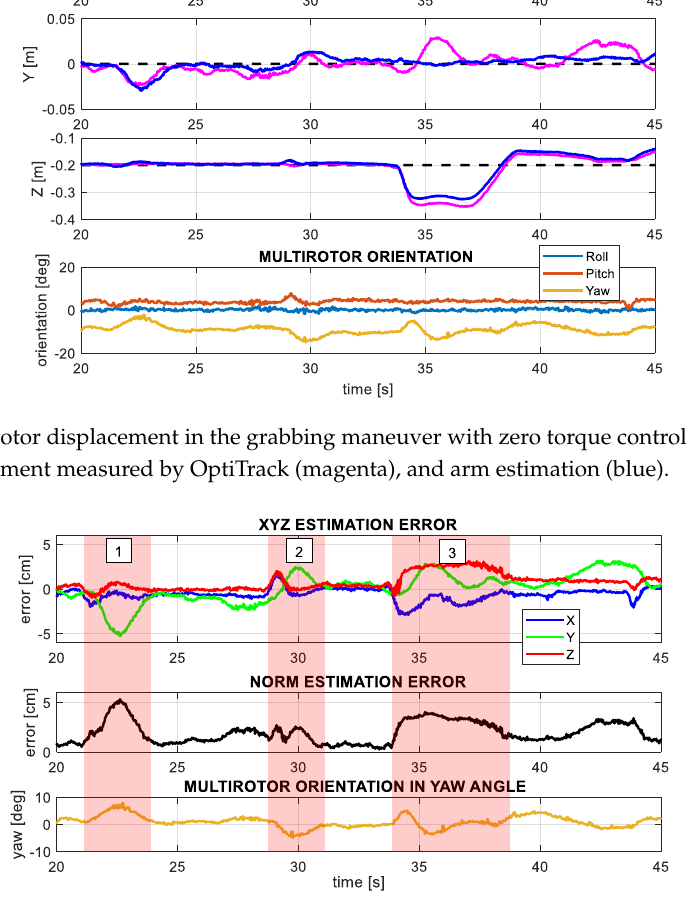
Figure 9. Position estimation error, using Opti-Track as ground truth. x -, y -, and z -axes error (up) and error norm (middle). The three shaded areas correspond to situations in which the platform is rotated in yaw and the error increased since the magnetic gripper was not firmly attached to the point.